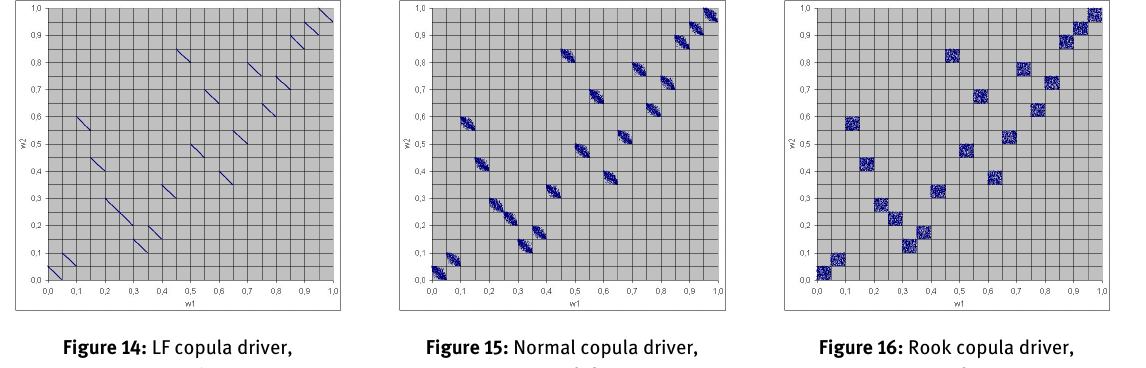
Figure 16: Rook copula driver, ρ =